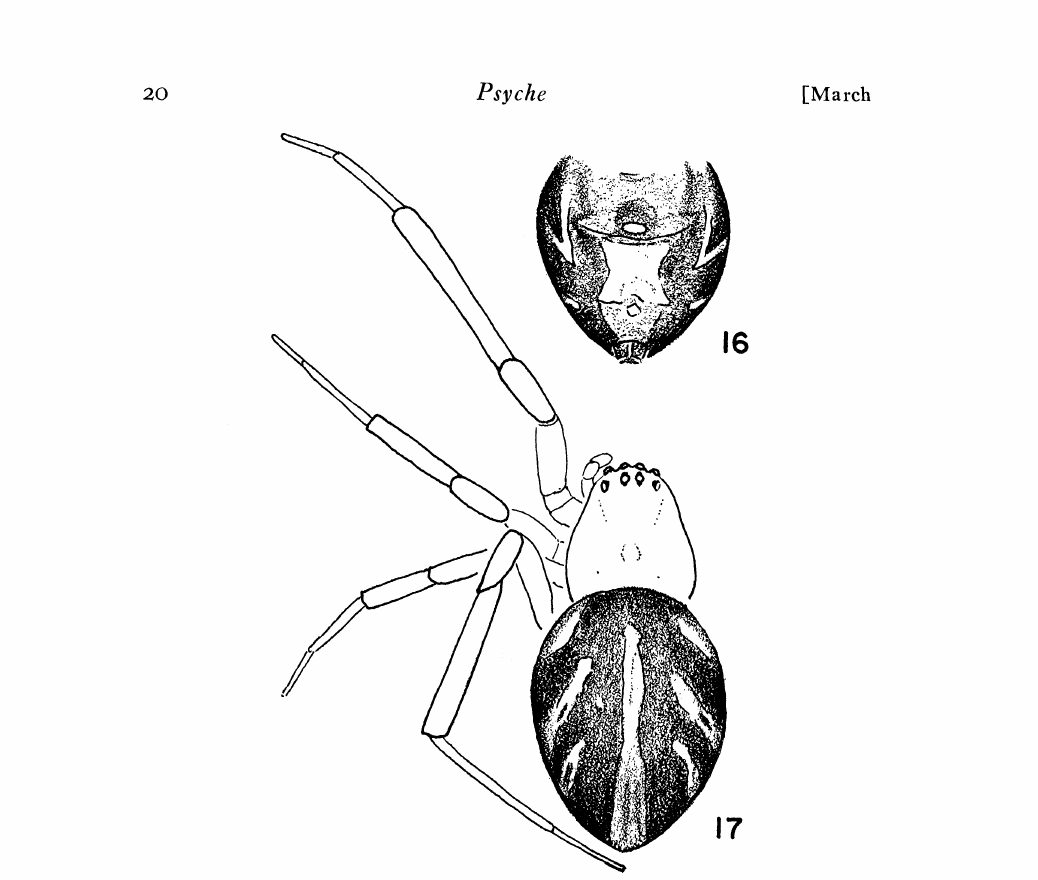
Figs. 16, 17. Latrodectus curacaiensis (Miiller), female. 16. Ventral view of abdomen. 17. Dorsal